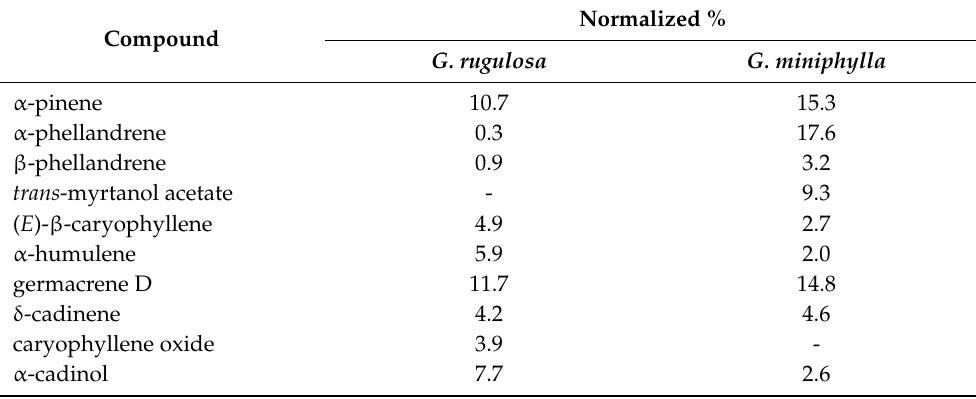
Table 3. Normalized abundance of major components in the EOs of G. rugulosa and G. miniphylla . Normalized % Compound G. rugulosa G. miniphylla α -pinene 10.7 15.3 0.3 17.6 0.9 3.2